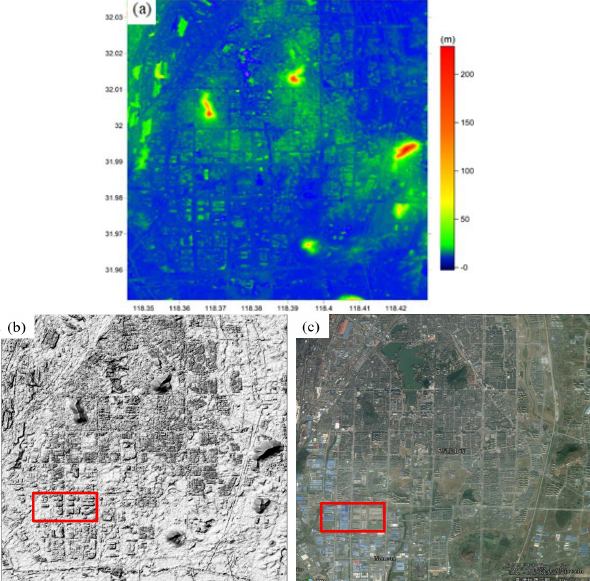
Figure 5 DEM of Maanshan area detected by iteration